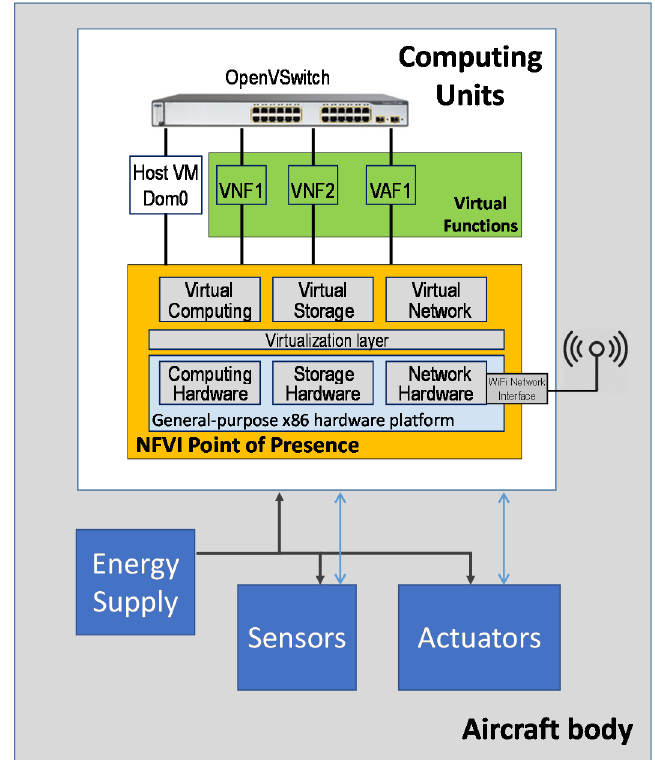
Figure 2. Backbone Mesh Network Node Architecture. VNF: virtual network function; VM: virtual machines; NFVI: network functions virtualization infrastructure; VAF: virtual application function.